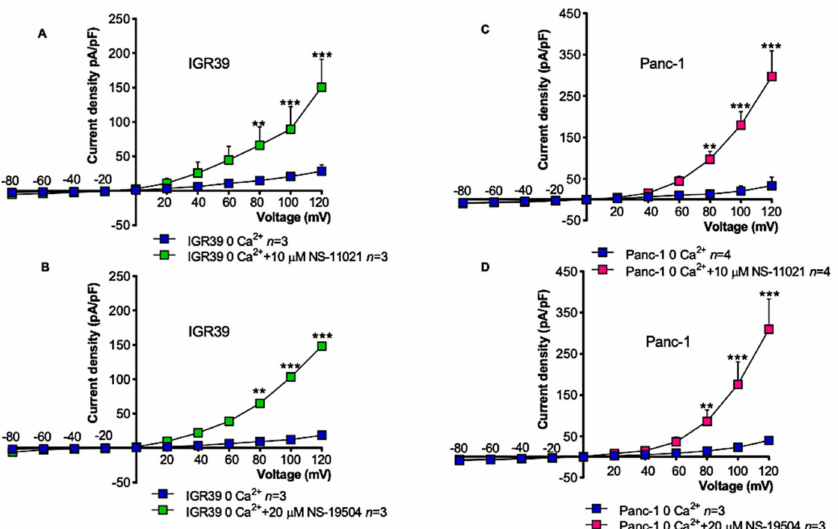
Figure 10. Effects of BK channel openers in absence of extracellular calcium in IGR39 and Panc-1 cells. Current density-to-voltage relationship measured in whole-cell patch-clamp experiments. The voltage protocol consisted of voltage steps from − 80 to +120 mV in +20 mV increments from a holding potential of − 50 mV. The duration of the voltage steps was 500 ms. Exposure to 10 µ M NS-11021 ( A , C ), or alternatively 20 µ M NS-19504 ( B , D ) induced BK current activation in both IGR39 and Panc-1 cells. ** p < 0.01 and *** p < 0.001, paired Student’s t -test. ( n ) refers to the number of